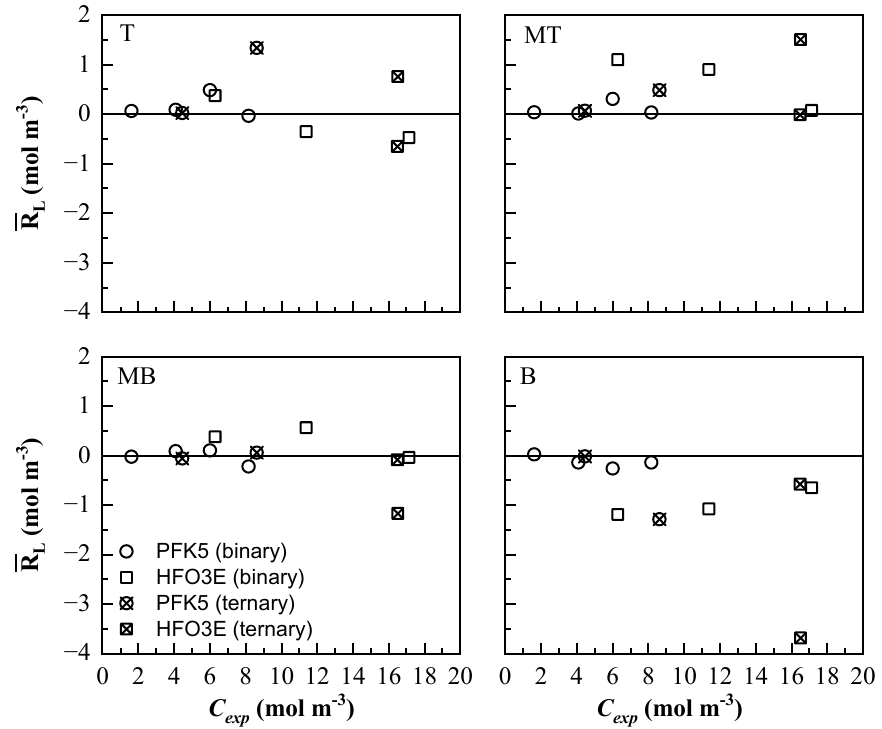
Figure 11. Mean residual value of the measurement lines at all times ( R L ) of the mixing process. The results of all the binary ( and (cid:3) ) and ternary ( ⊗ and (cid:2) ) mixtures are represented for PFK5 and HFO3E, respectively.